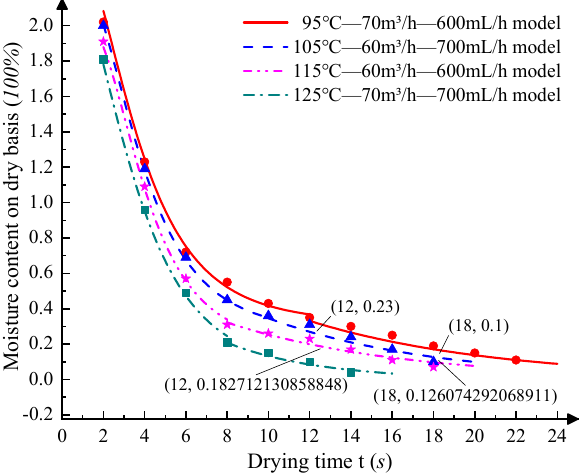
Figure 15. Model curve of yeast particle dry based moisture content as a function of time contrasting with experimental values.